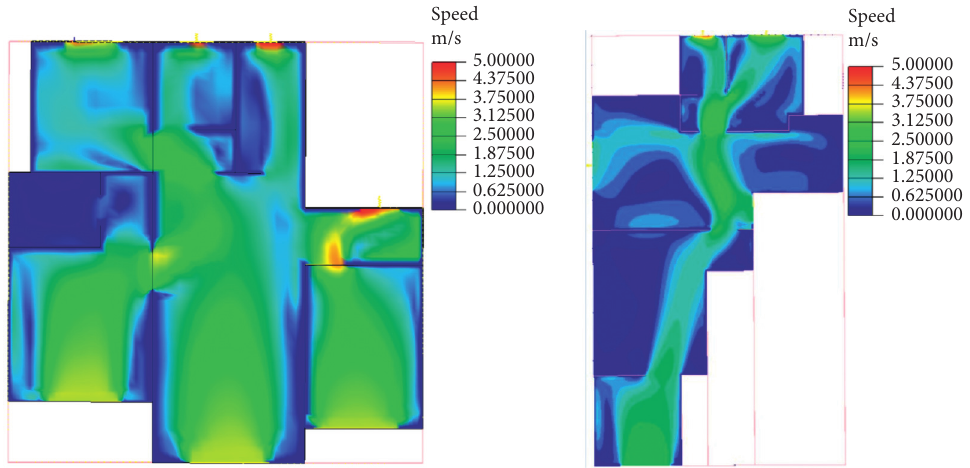
Figure 10: Speed distribution of two house types A and B under condition 2.